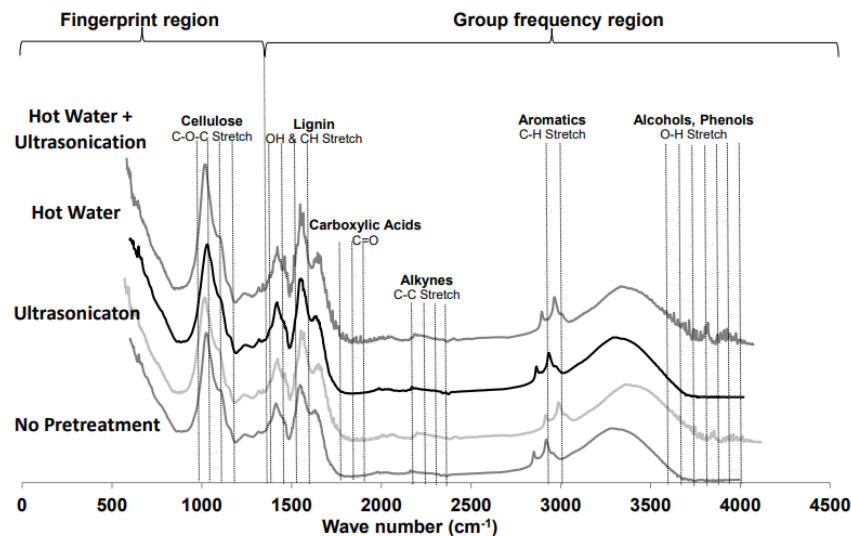
Figure 2. Chemical structure of biogas produced from the digestion of cotton gin trash (FTIR spec- tra). Table 2. Feedstock composition for anaerobic co-digestion.